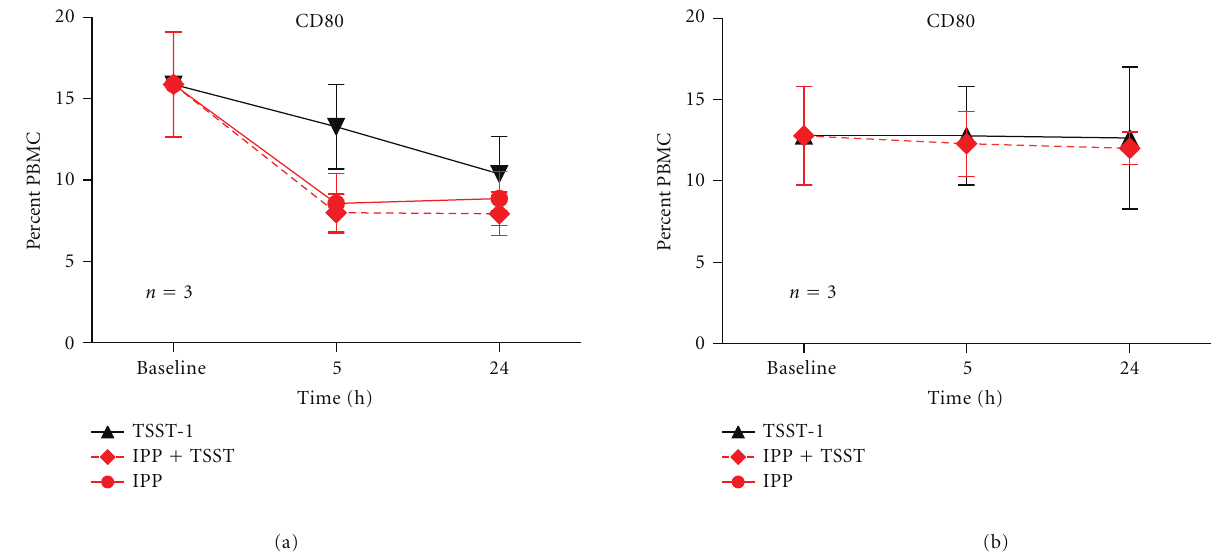
Figure 2: Modulation of CD40, CD86, HLA-DR and CD80 on APCs by IPP-activated γδ T cells . PBMC were cultured overnight in the presence of IPP or absence of IPP before stimulation with 1nM of TSST-1 (a). Data (mean ± SEM) for expression of CD40, CD86, HLA-DR and CD80 were shown after various time intervals following TSST-1 stimulation, and the numbers of healthy donors studied for each co- receptor are as indicated. Baseline values were obtained from PBMC treated with RPMI growth medium alone. To determine the influence of IPP-activated γδ T cells on receptor expression following TSST-1 stimulation, comparisons were made between IPP + TSST-1 (dashed red lines) versus TSST-1 alone (solid black line), and significant di ff erences were denoted by ( ∗ ). To confirm that any observed di ff erence in receptor expression was due to the presence of activated γδ T cells, a cognate group of PBMC were depleted of γδ T cells ( < 0 . 1%) and studied in parallel experiments (b). To determine the influence of TSST-1 on IPP-activated γδ T cells, comparisons were made between IPP + TSST-1 versus IPP alone. Overnight IPP treatment significantly up-regulated CD40 expression at 3hours and 6hours after TSST-1 stimulation ( ∗ P < . 05, student’s t test), and down-regulated CD86 expression at 3h after TSST-1 stimulation ( ∗ P < . 05). No other significant di ff erences in receptor expression were observed for the other co-stimulatory